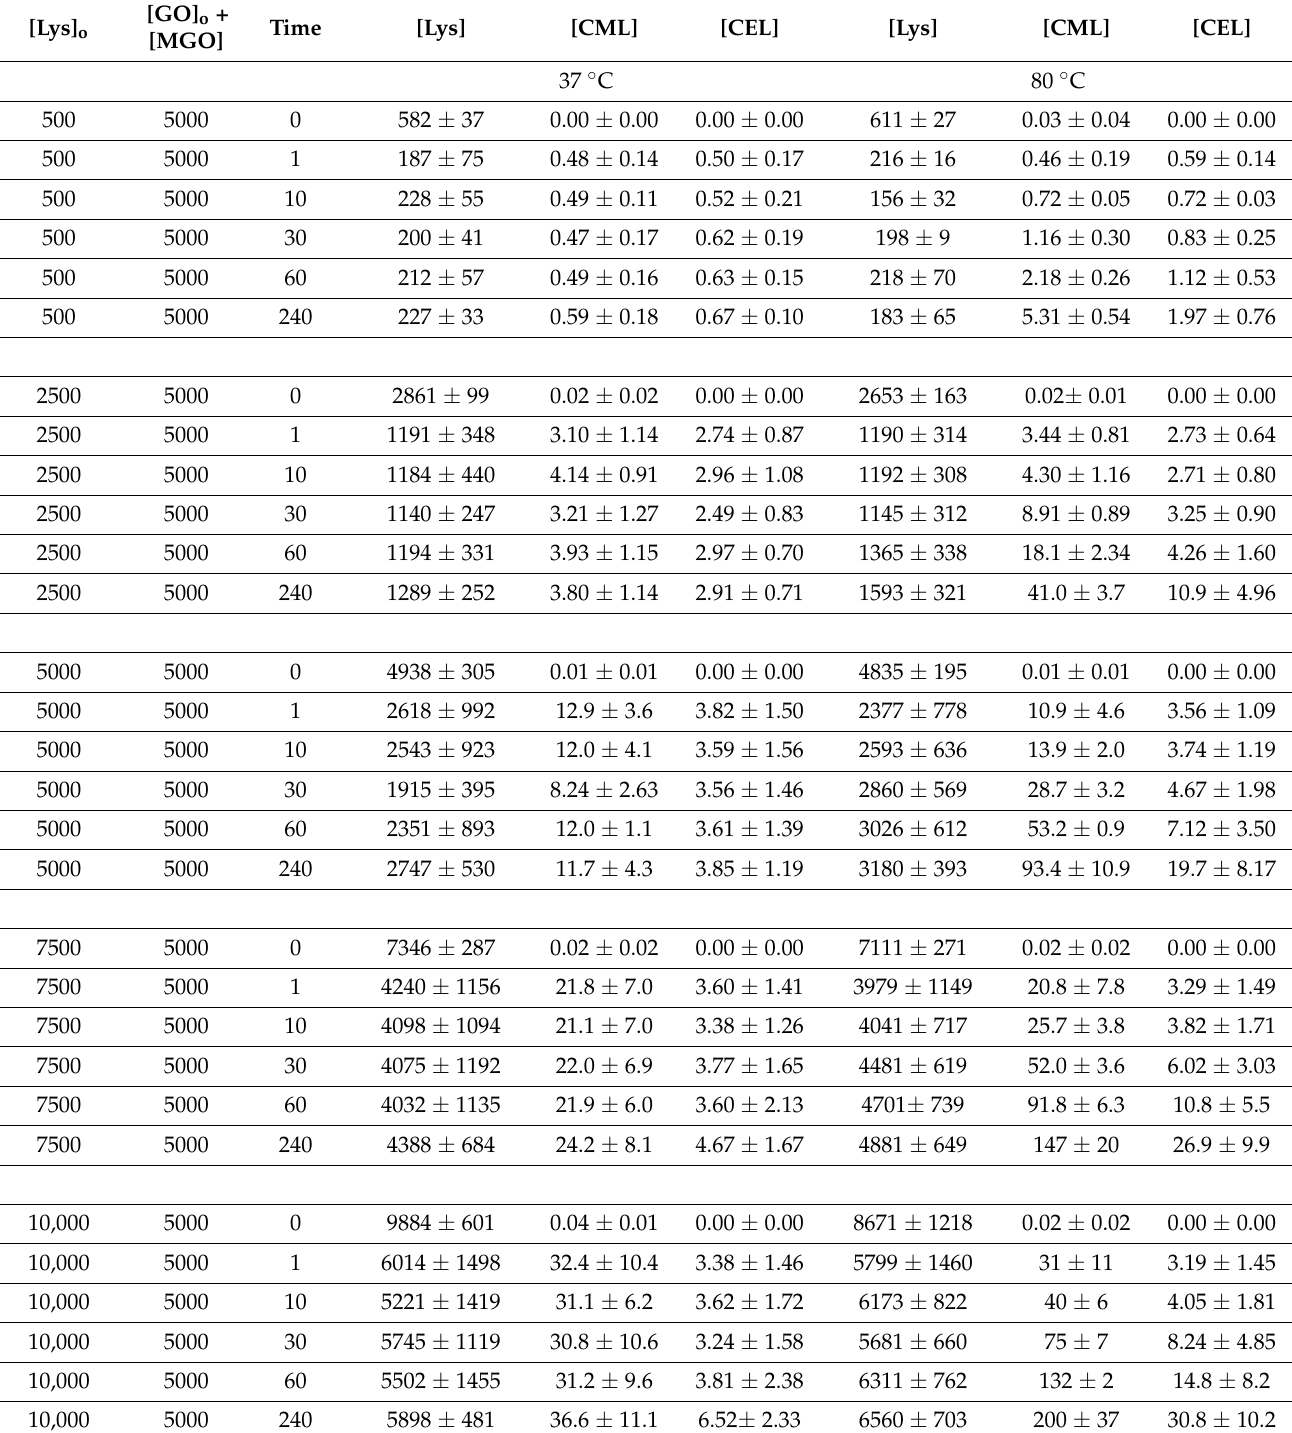
Table 3. Concentration (mean ± SD; µ M) of remaining Lys and formed CML and CEL from